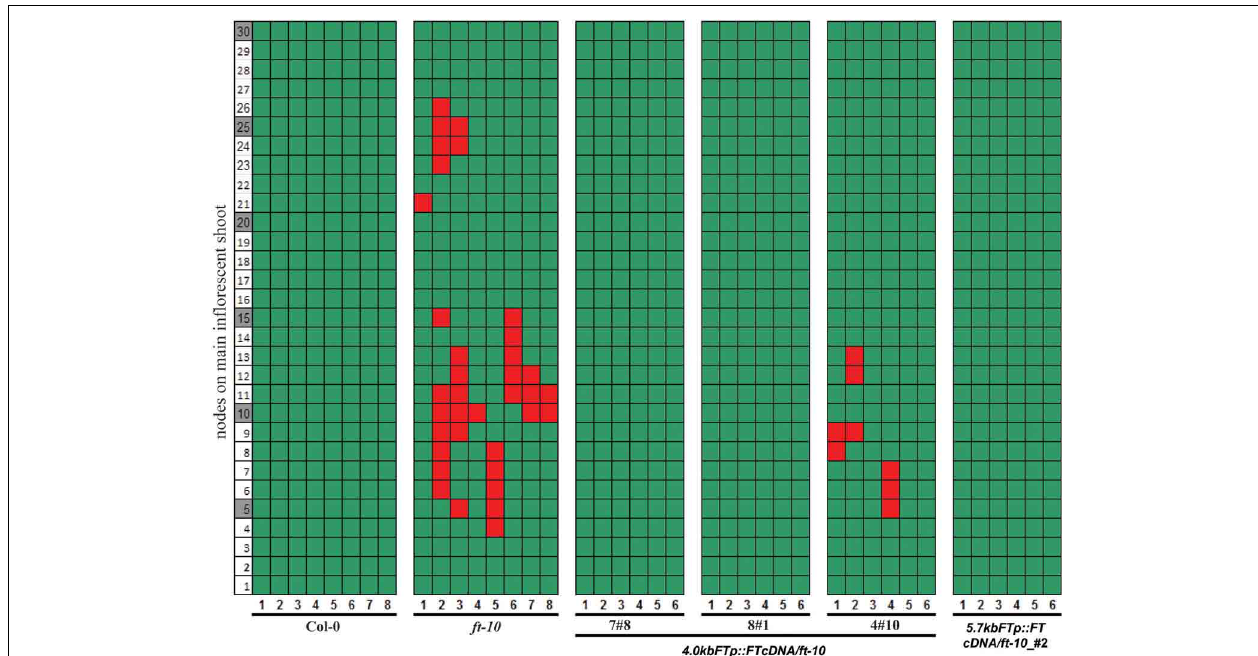
FIGURE 4 | Reversion of ft mutants is abolished by expressing FT under the control of a 4.0kb FT promoter. Reversion phenotype of ft-10 plants carrying constructs to drive FT cDNA by 5.7 and 4.0kbFTp were measured. Three independent transgenic lines are